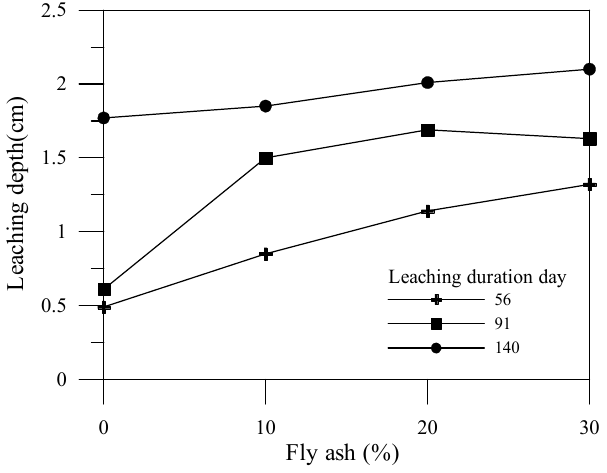
Figure 10. Effects of fly ash admixture amount on leaching depth and duration.